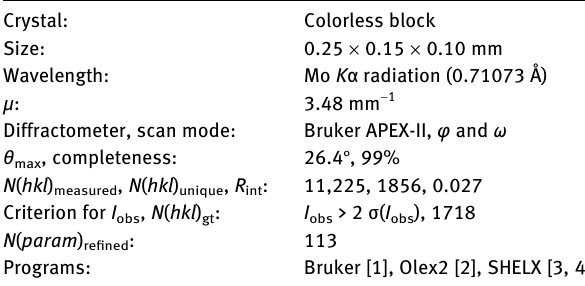
Table  : Data collection and handling. Crystal: